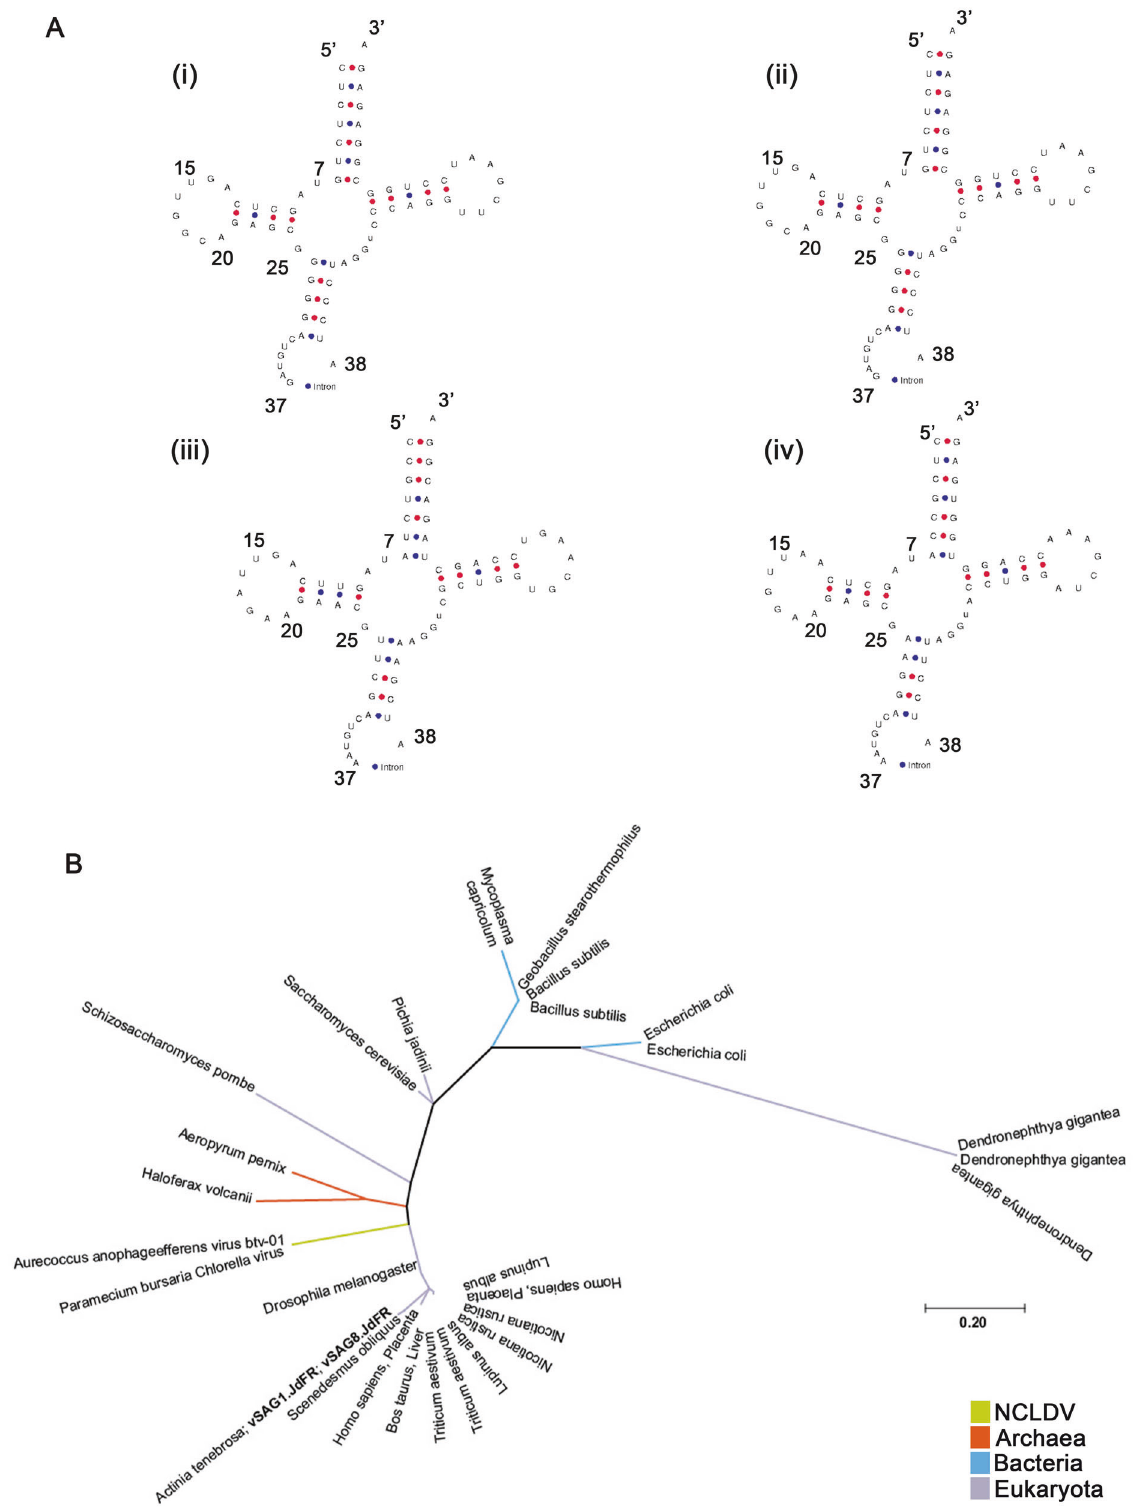
Fig. 4 tRNATyr structure and phylogeny. A Predicted tyrosine tRNA (tRNATyr) gene structure with intron at the canonical position between nucleotides 37 and 38 of the precursor tRNA i . vSAG1.JdFR; ii . vSAG8.JdFR; iii . Aureococcus anophagefferens virus (AaV); iv . Paramecium bursaria Chlorella virus (PBCV). B Phylogenetic position (maximum likelihood tree) of vSAGs based on tRNA Tyr